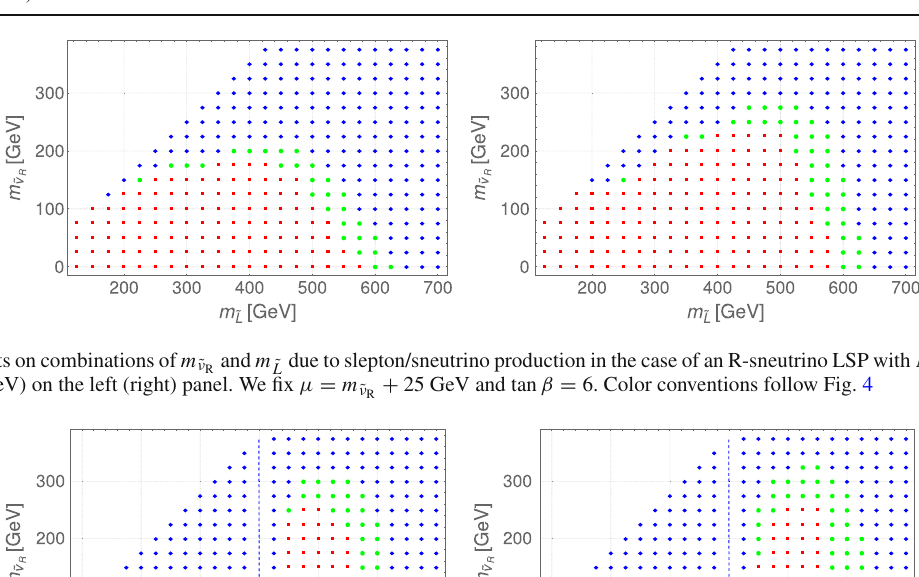
Fig. 8 Constraints on combinations of m ˜ ν and m ˜ due to slepton/sneutrino production in the case of an R-sneutrino LSP with M 1 = M 2 = 2 TeV L R ( M 1 = M 2 = 1 PeV) on the left (right) panel. We fix μ = 400 GeV and tan β = 6. Color conventions follow Fig.